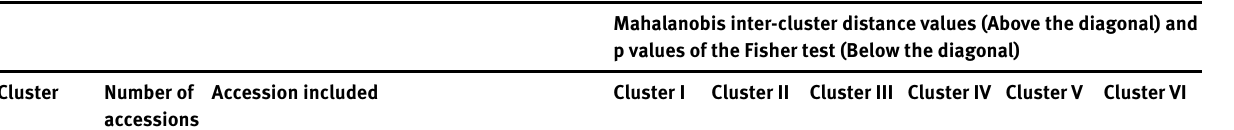
Table 8: Clustering pattern, average inter-cluster mahalanobis D 2 distances and Fisher test p-values matrices for Dioscorea bulbifera genotypes collected in Cameroon